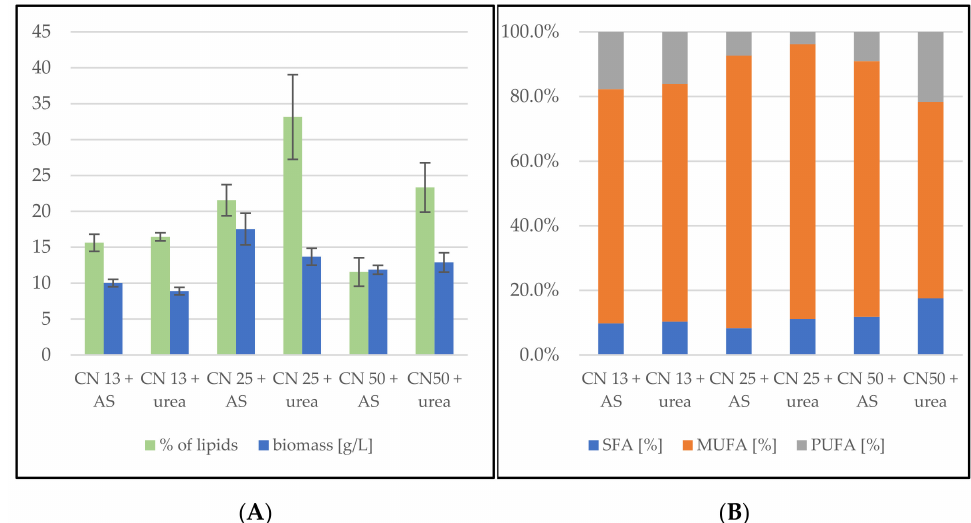
Figure 2. Sporidiobolus pararoseus screening cultivation on SCG hydrolysate media with different C/N ratios and different nitrogen source. ( A ) Biomass production (g/L) and total lipid production [%]; ( B ) fatty acid profile